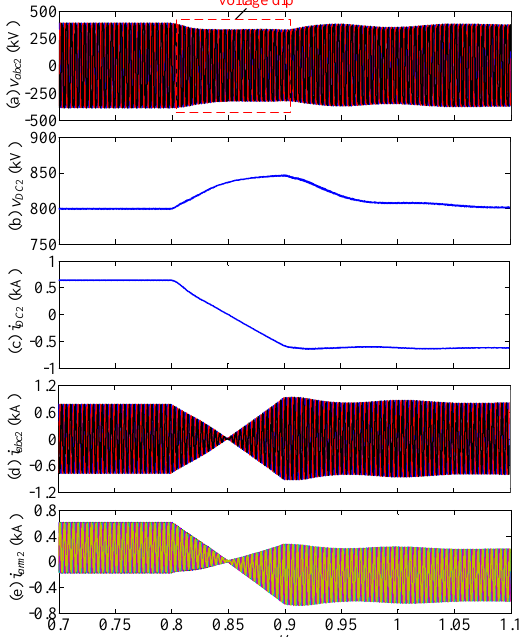
Figure 6. Power reversal waveforms of MMC 2 in the DC/DC converter: ( a ) three-phase voltages; ( b ) DC voltage; ( c ) DC current; ( d ) three-phase currents; and ( e ) arm currents.